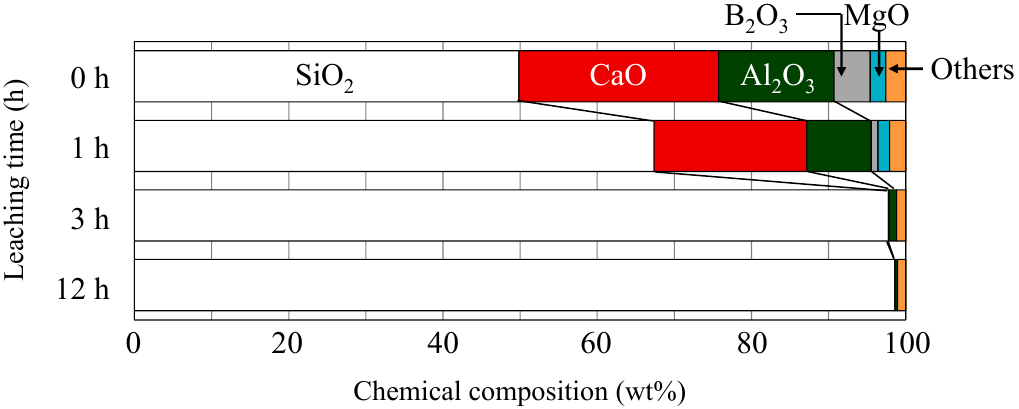
Figure 3. Chemical compositions of the non-porous (0-h leaching time) and porous glass cloths estimated from the X-ray fluorescence (XRF) measurements. The “Others” category includes TiO 2 , Na 2 O, K 2 O, Fe 2 O 3 , and SrO.